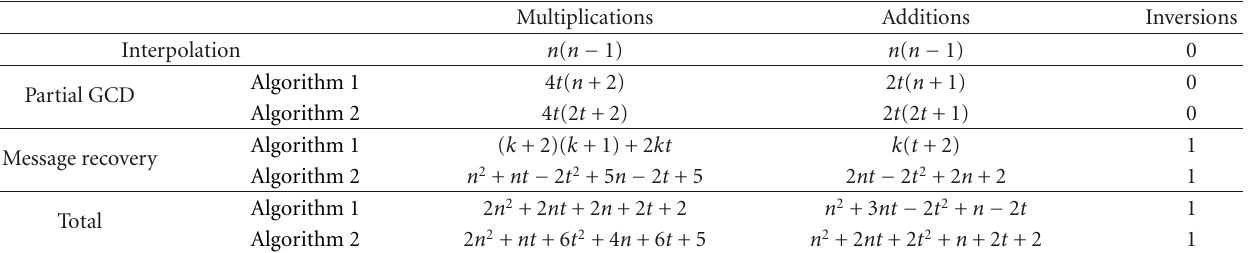
Table 1: Direct implementation complexities of syndromeless decoding algorithms